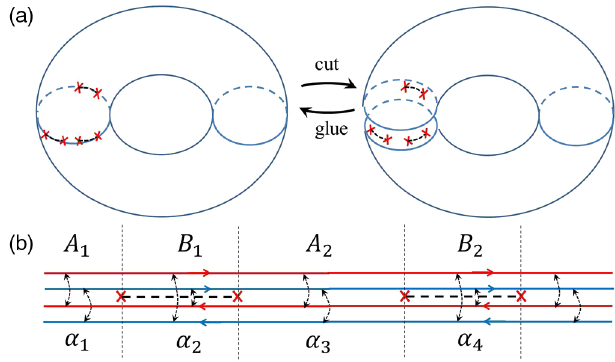
FIG. 3. Topological degeneracy seen from the edge-state per- spective. (a) The dislocations are oriented along a single line, and then the system is cut along the line, yielding gapless counterpropagating edge states along the line. The original FQH state is obtained from gluing the system back together by turning on appropriate interedge-tunneling terms. (b) Depiction of the two branches (red and blue) of counterpropagating edge excitations. The arrows between the edge states indicate the kinds of electron-tunneling terms that are added. Away from the dislocations, in the A regions, the usual electron-tunneling þ (cid:2) terms involving tunneling between the same layers, (cid:2) y eLI eRI H : c : , are added. In the regions that include the branch cuts separating the dislocations, twisted-tunneling terms are added: þ (cid:2) y þ H : c : (cid:2) (cid:2) (cid:2) indicate the midpoints of (cid:2) y eL 2 eL 1 i eR 1 eR 2 the A or B